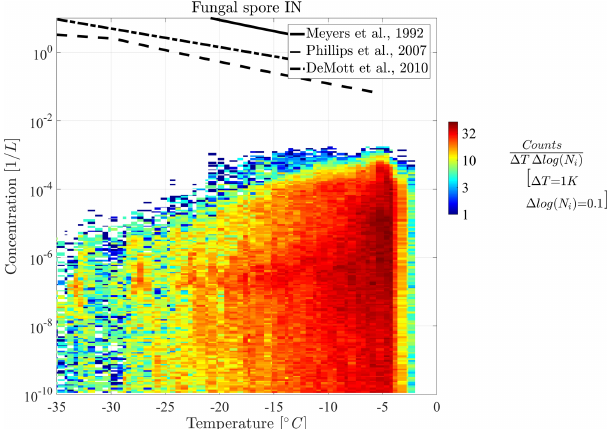
Figure 5. Two-dimensional histogram of concentration vs. temper- ature for bacteria INPs.